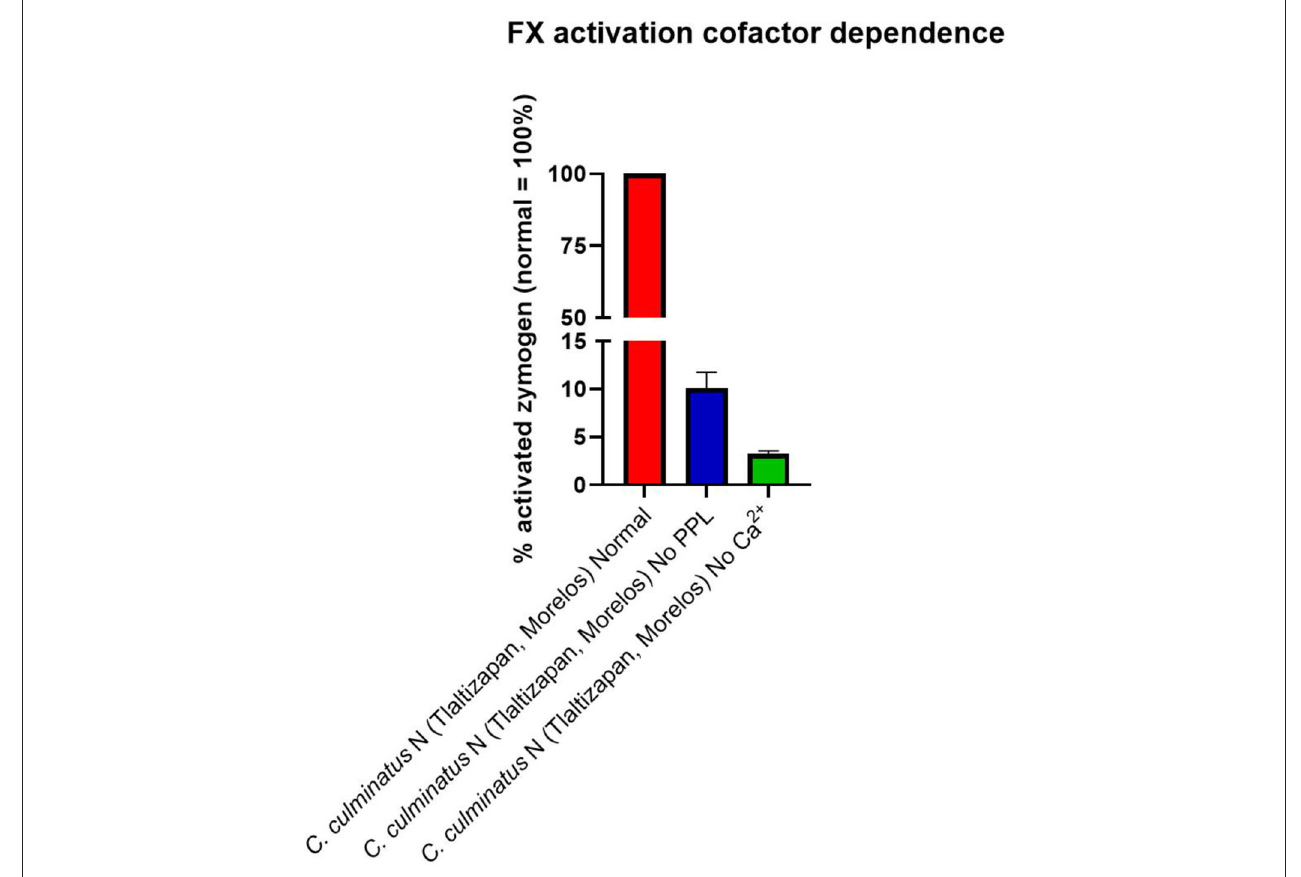
FIGURE 10 | Fluorometry graph showing activation of FX by venom from a neonate C. culminatus specimen with and without coagulation cofactors (Ca 2 + and phospholipids). Activation is expressed as the relative percentage of zymogen converted to its active form, with the normal condition (i.e., both Ca 2 + and phospholipidss present in the incubation) as the 100% benchmark. Values are n = 3 mean ±